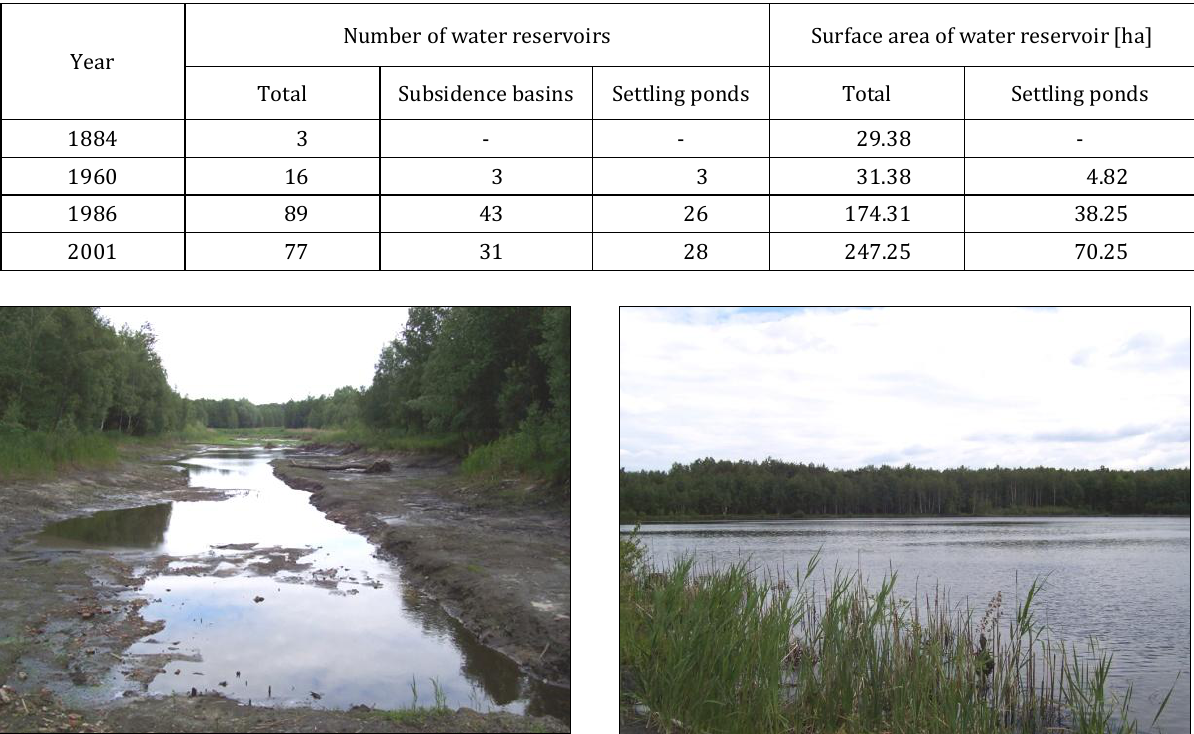
Fig. 3. Small water reservoir in the valley of the Krywałdzki Fig. 4. “Zacisze” water reservoir ( E. Jaruchiewicz